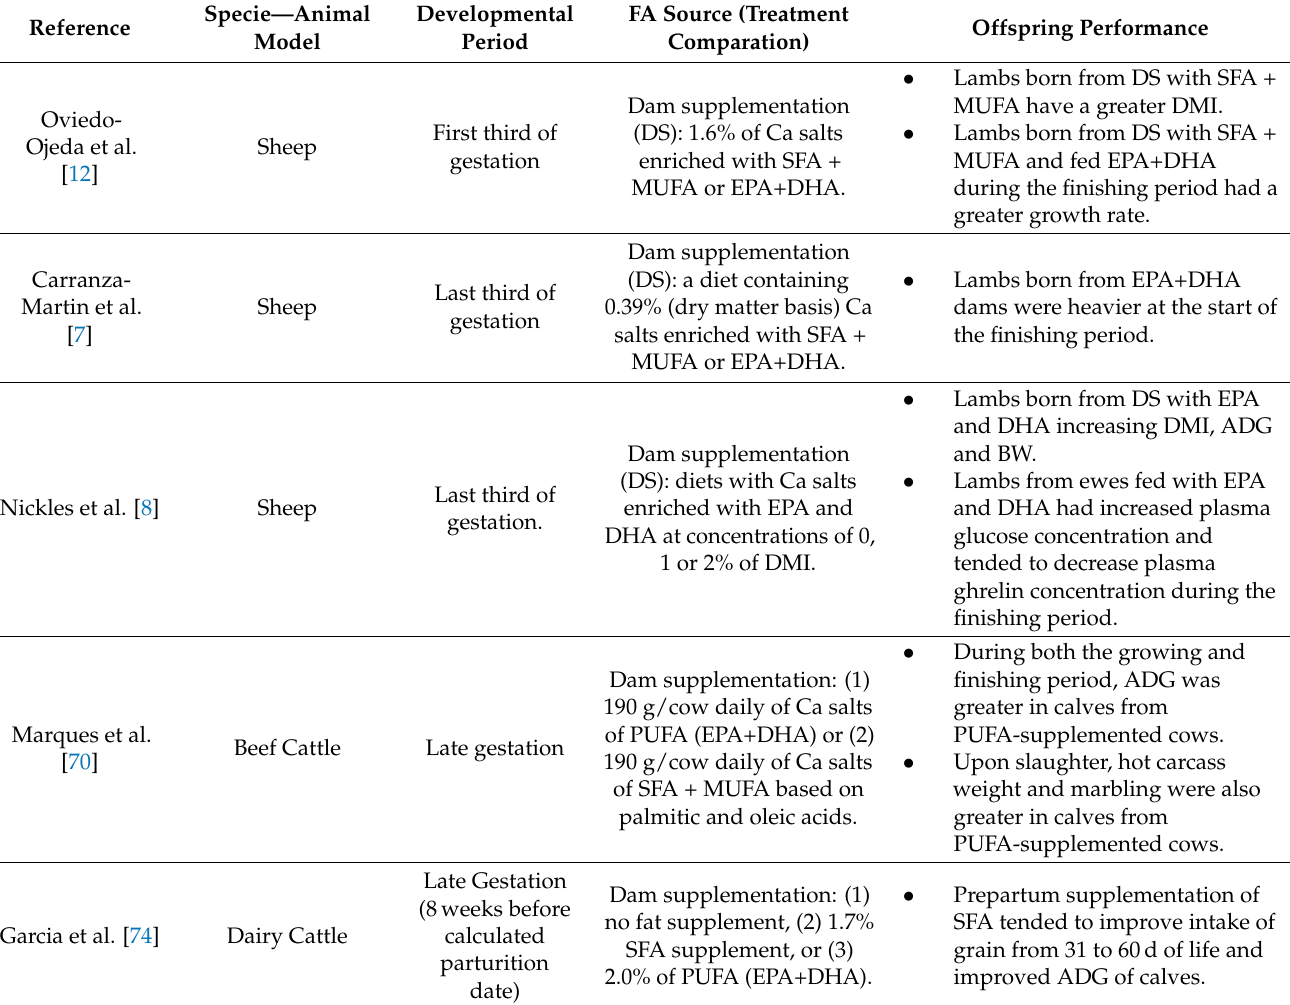
Table 1. Effect of dam FA supplementation on offspring growth and